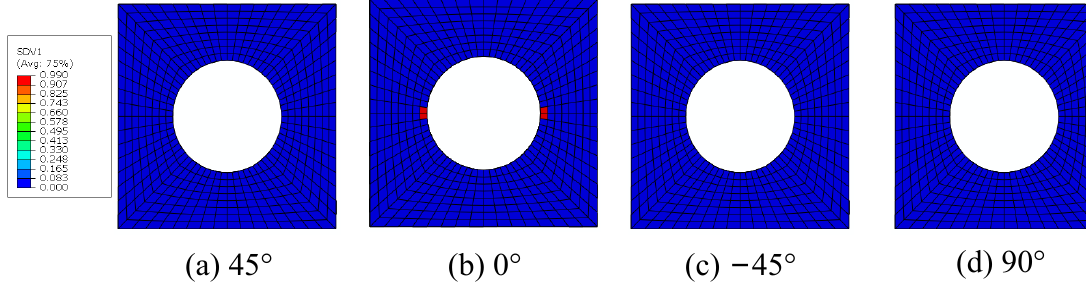
Figure 24. The initiations regions for fiber breakage.